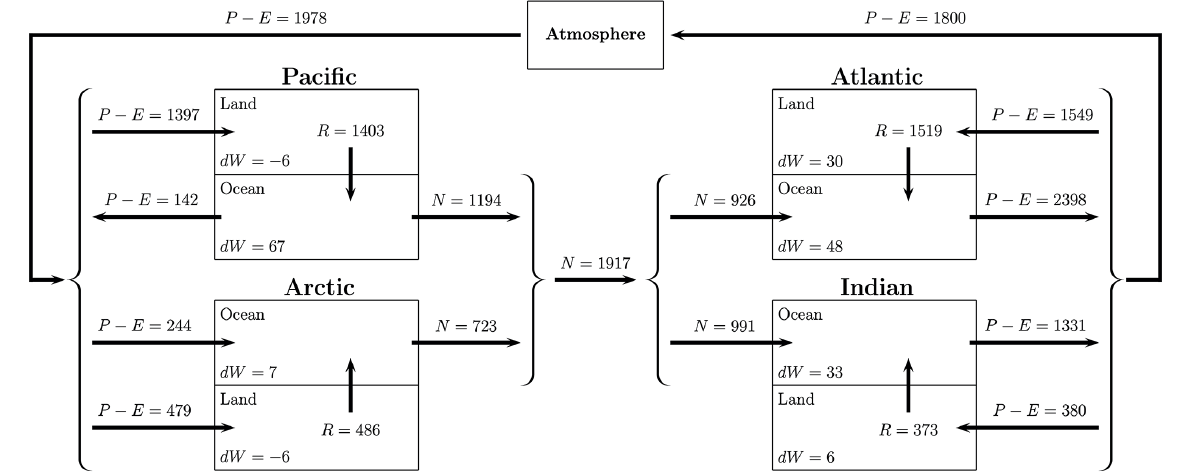
Figure 5. Diagram of the mean values of the WT of the study regions. Units are in gigatonnes per